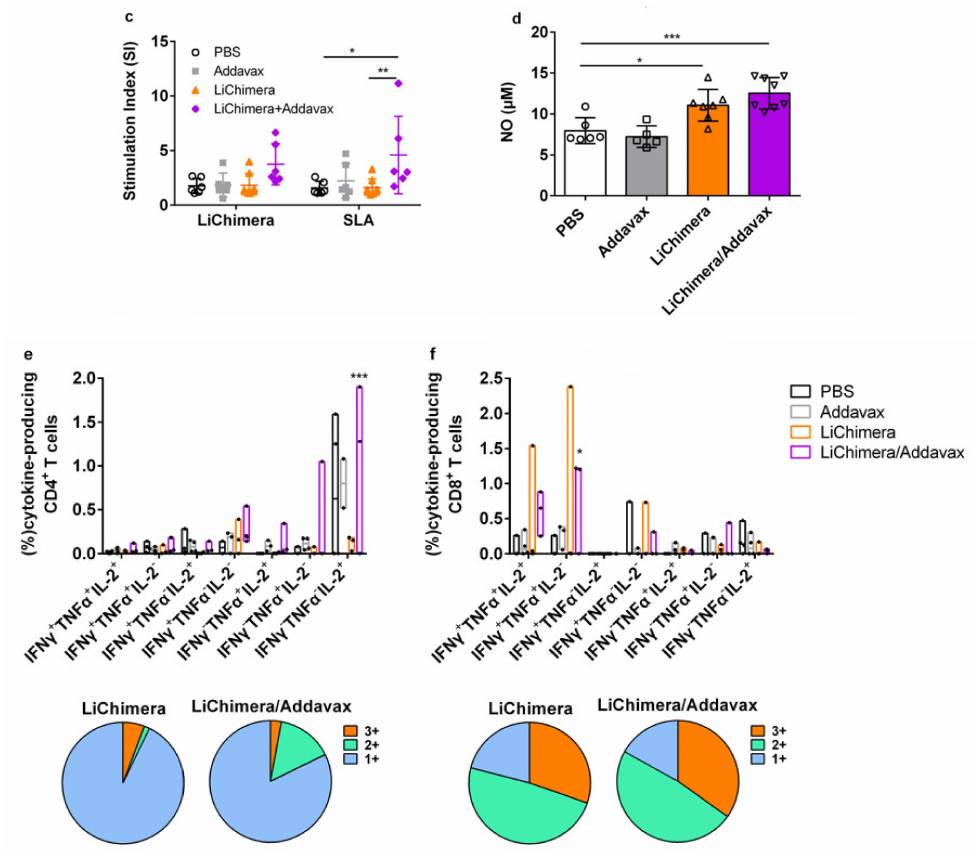
Figure 10. Detection of protective e ffi cacy of the LiChimera vaccination against L. infantum challenge and evaluation of the cellular immune responses in short-term vaccinated mice. The BALB / c mice